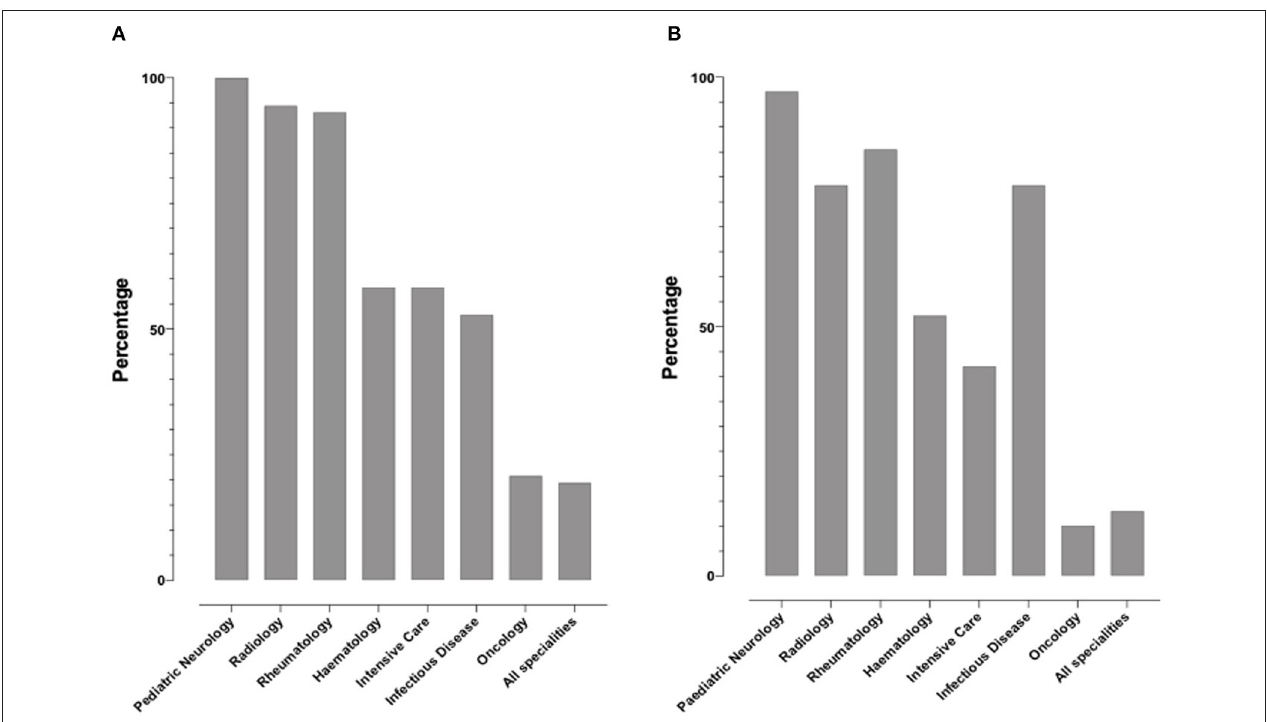
FIGURE 3 | Percentage of specialties respondents indicated should involve in the treatment of the two cases. (A) Bar chart illustrating the percentage of respondents who have indicated which specialties should be involved in Case 1, (B) Respondents were also asked to indicated which specialties should be involved in treating Case